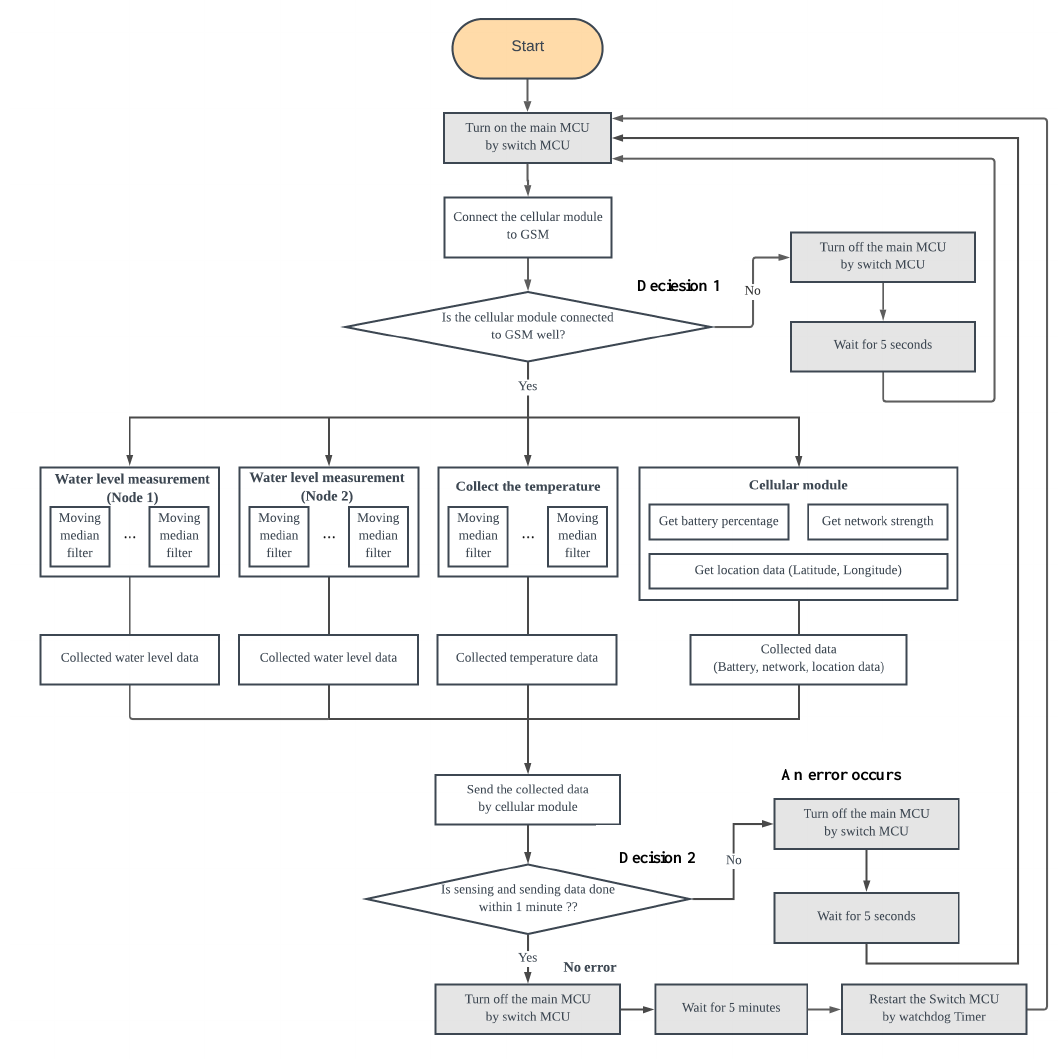
Figure 8. Flowchart of the UWLD system with dual-target sensing and dual MCUs